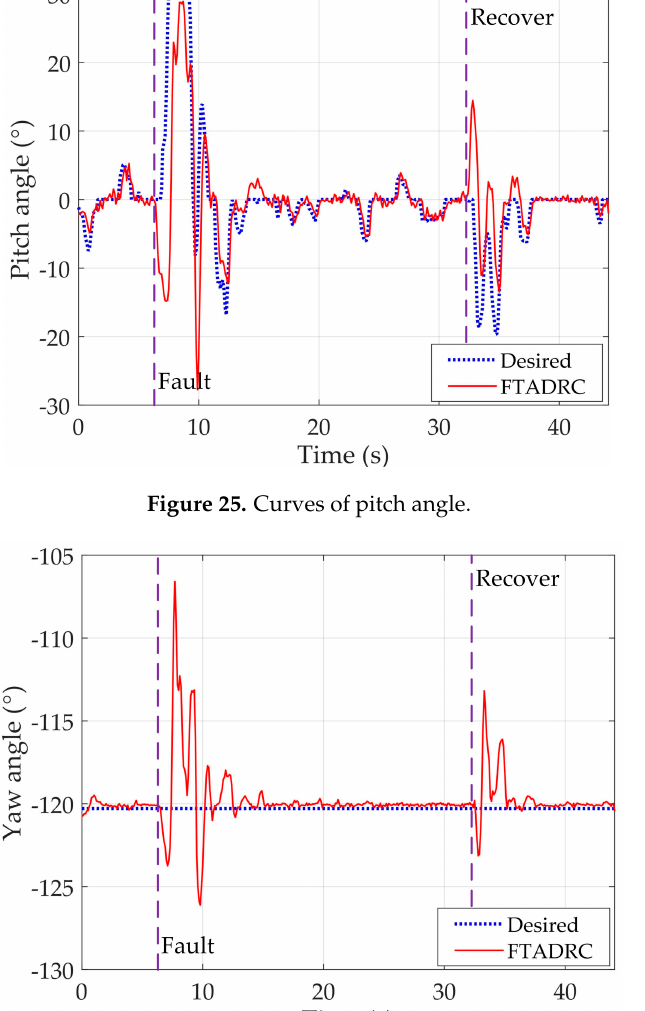
Figure 27. Curves of disturbance estimation. Case 3. Wind and damaged propeller